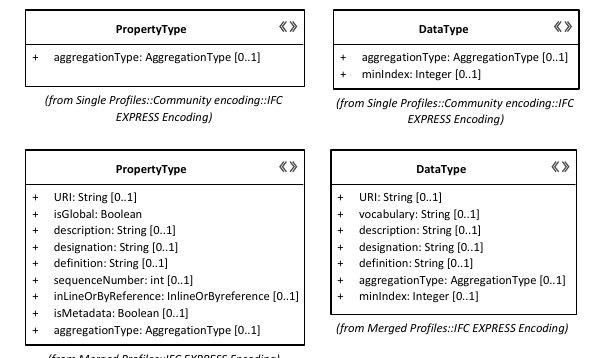
CGP. Figure 10 shows an example of a datatype with semantics both from the CGP and the IFC EXPRESS Encoding Profile.